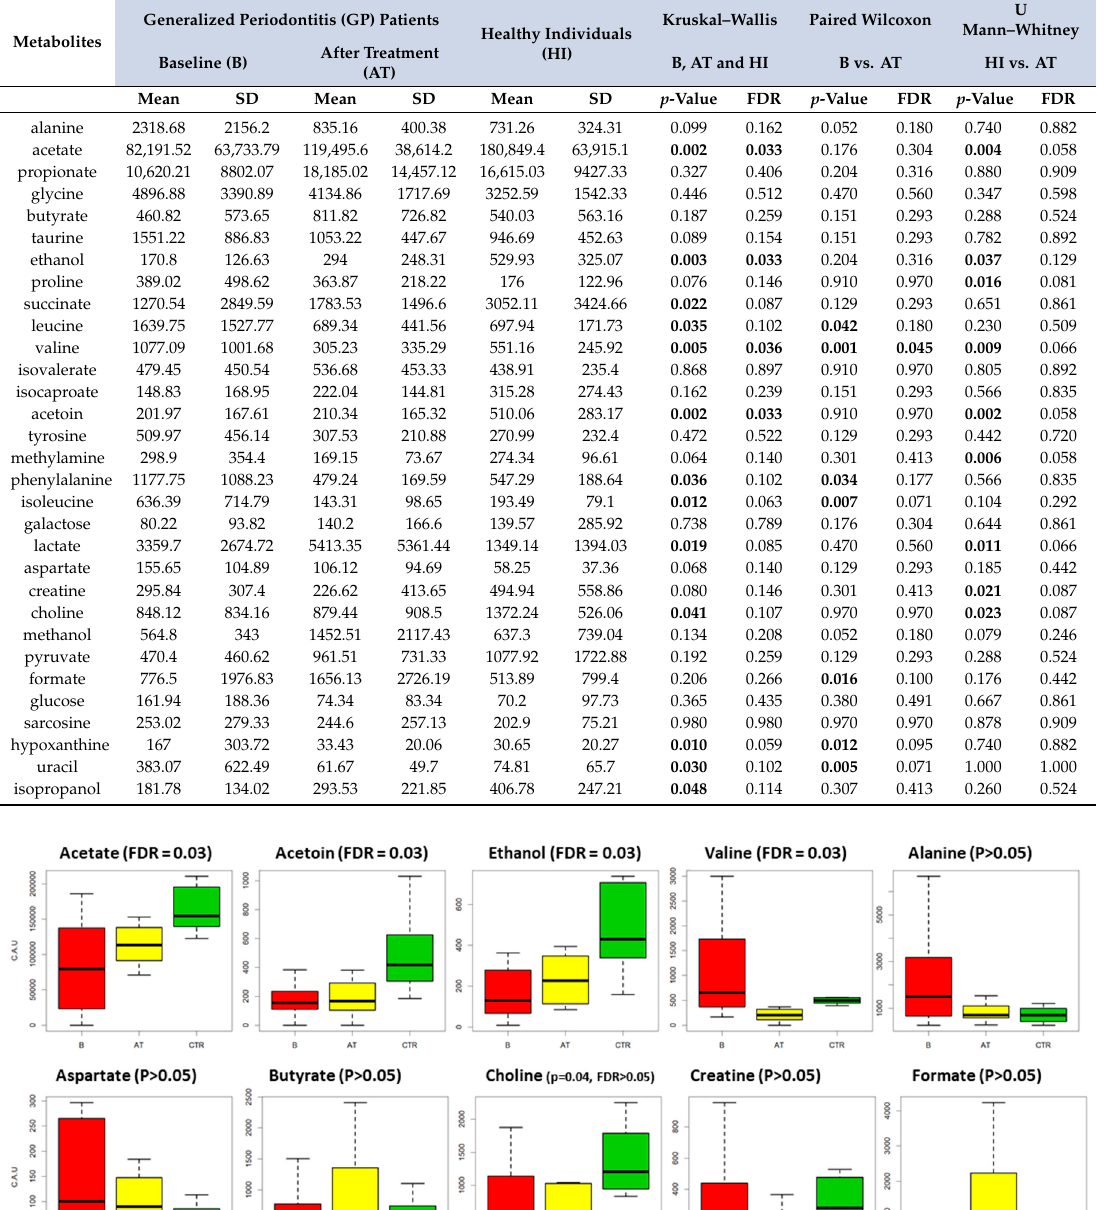
Table 2. Salivary concentration of metabolites in HI and GP patients at baseline and 3 months post-treatment. p -values, adjusted p -values and false discovery rate (FDR) are reported for overall comparison and pairwise analyses.